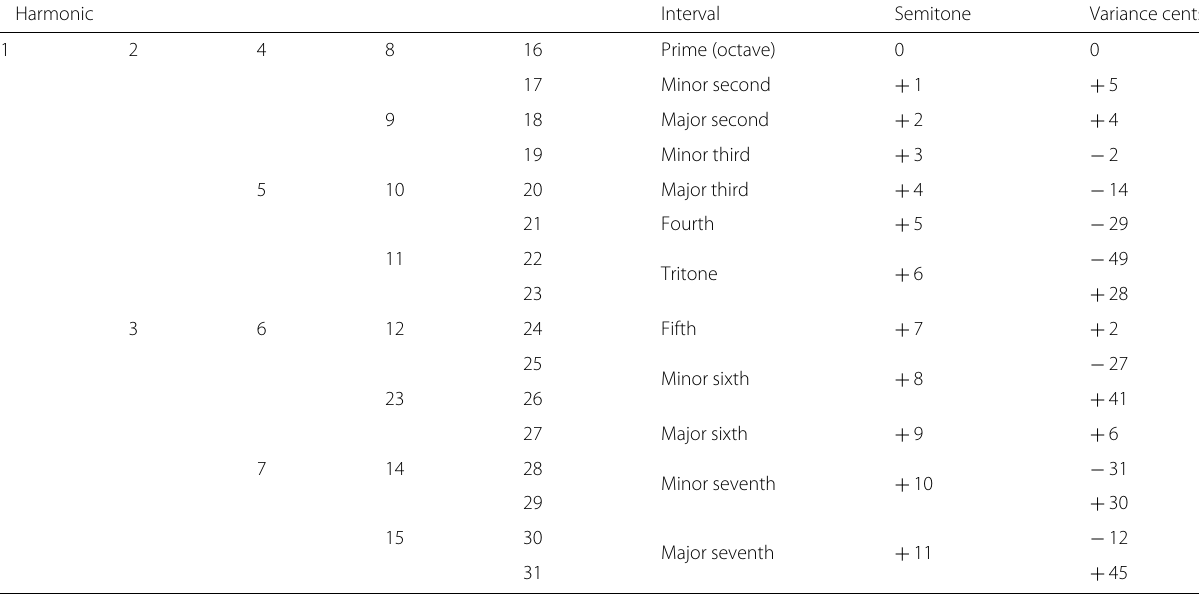
Table 1 Frequency relationships between the overtones of a reference note n and its upper octave Harmonic Interval Semitone Variance cents